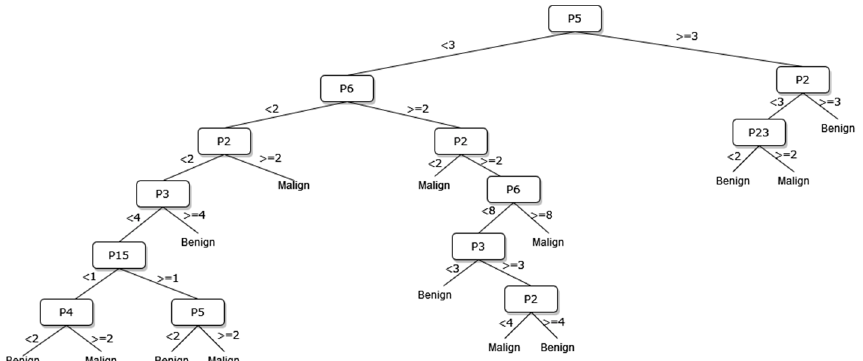
Figure 7. The DT of 8 sonographic signs.